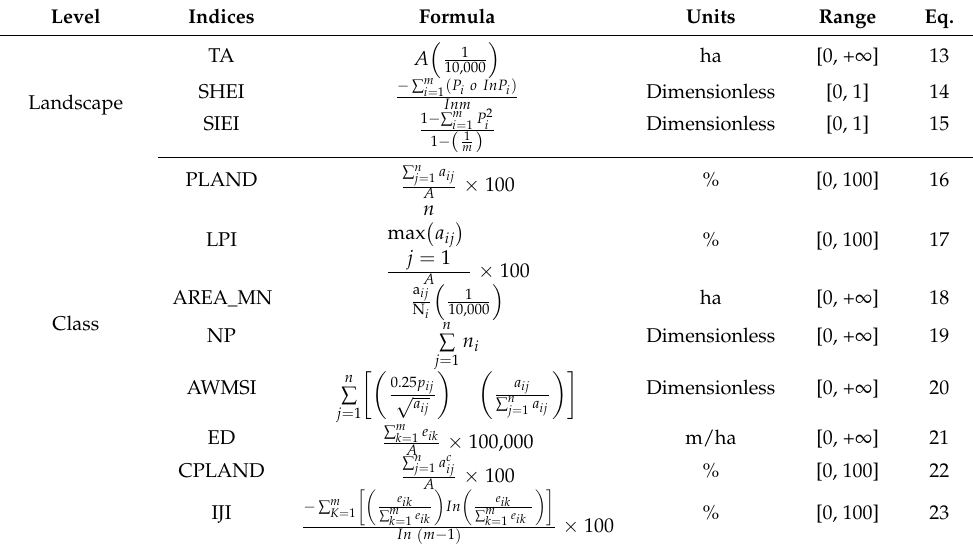
Table 4. Landscape metrics.